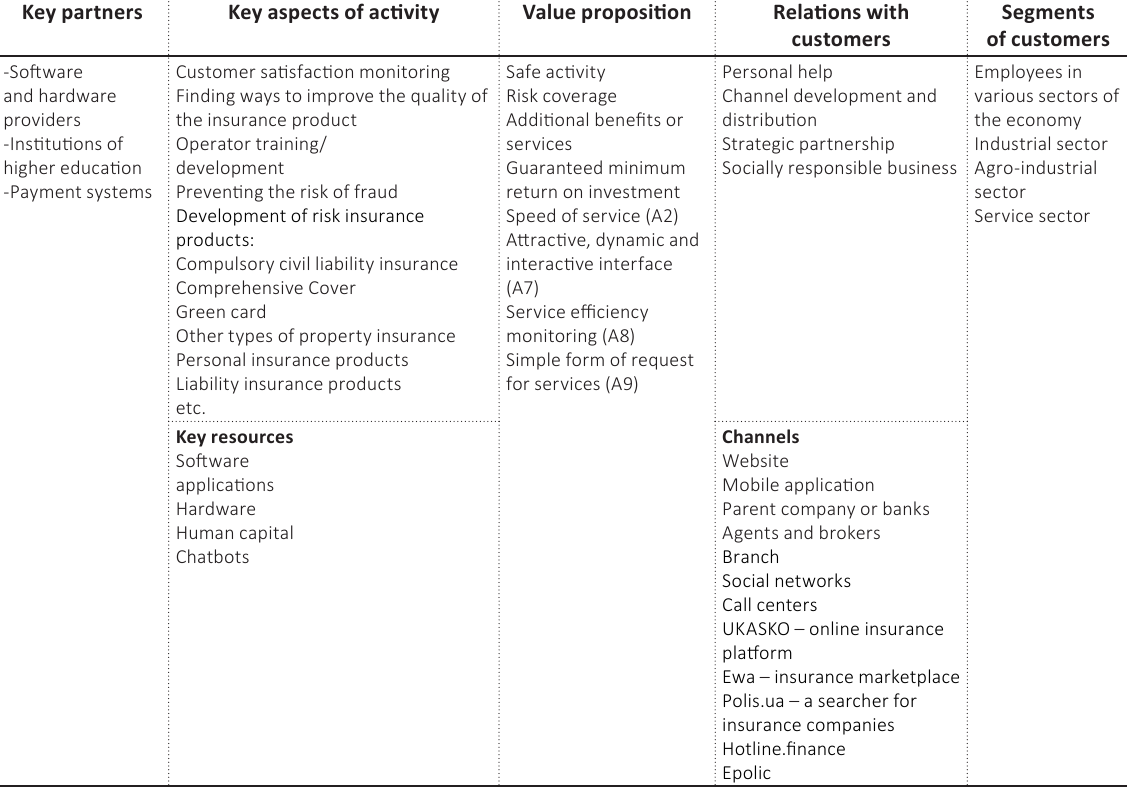
Table 10. Business model of insurance companies from the NON-LIFE